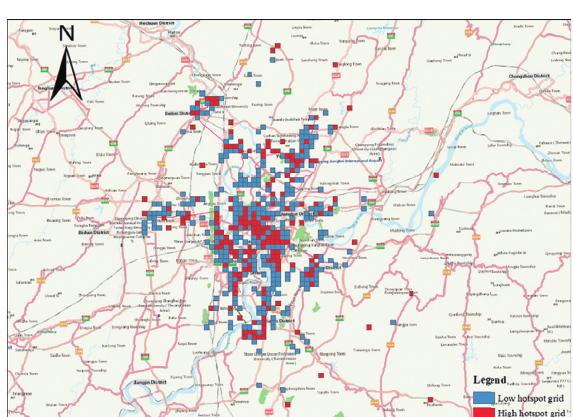
Figure 4: Model prediction results.